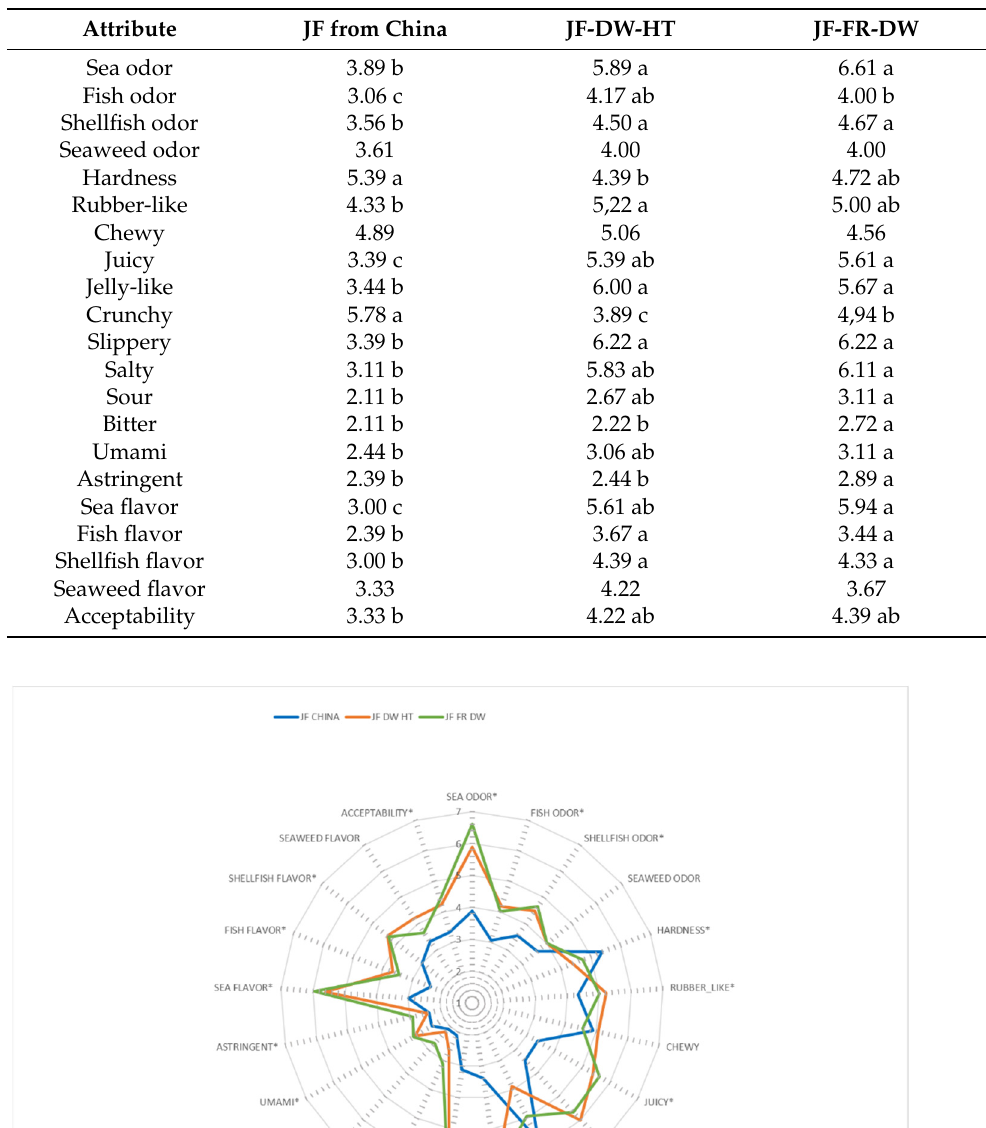
Table 4. ANOVA analysis of DA intensity scores and acceptability by sample. Different letters correspond to significantly different means.